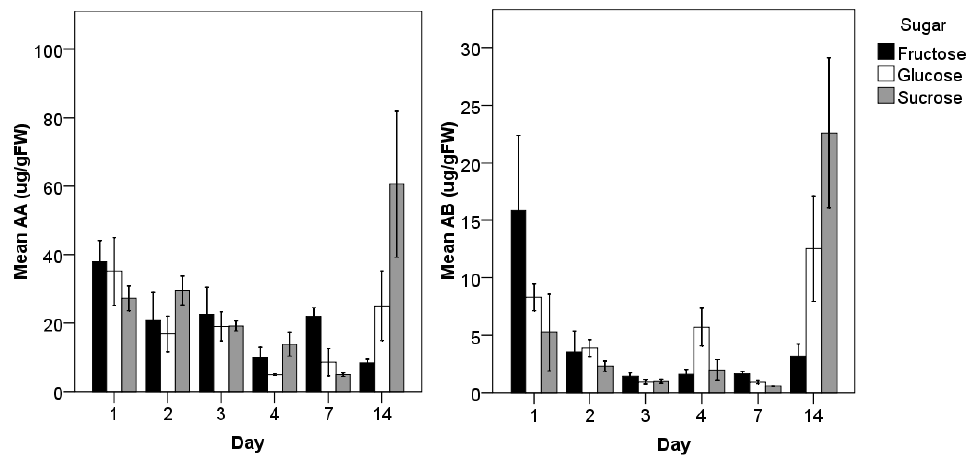
Figure 6. AA and AB levels in A. annua seedlings grown 14 days in glucose, fructose, or sucrose. Bars are